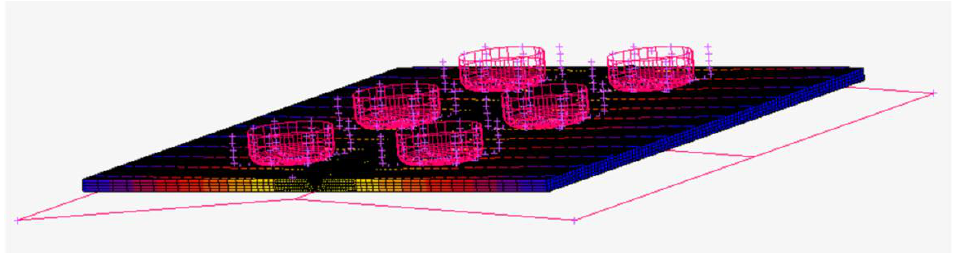
Figure 4. Welding simulation jig model as rigid body.